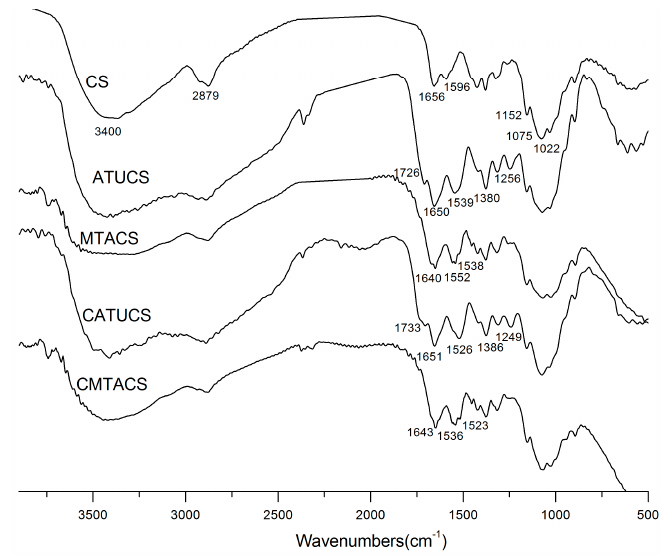
Figure 1. FT-IR spectra of chitosan (CS), acetyl thiourea chitosan (ATUCS), 3-methyl-1,2,4-triazolyl chitosan (MTACS), chloracetyl thiourea chitosan(CATUCS) and 3-chloromethyl-1,2,4-triazolyl chitosan (CMTACS) derivative.